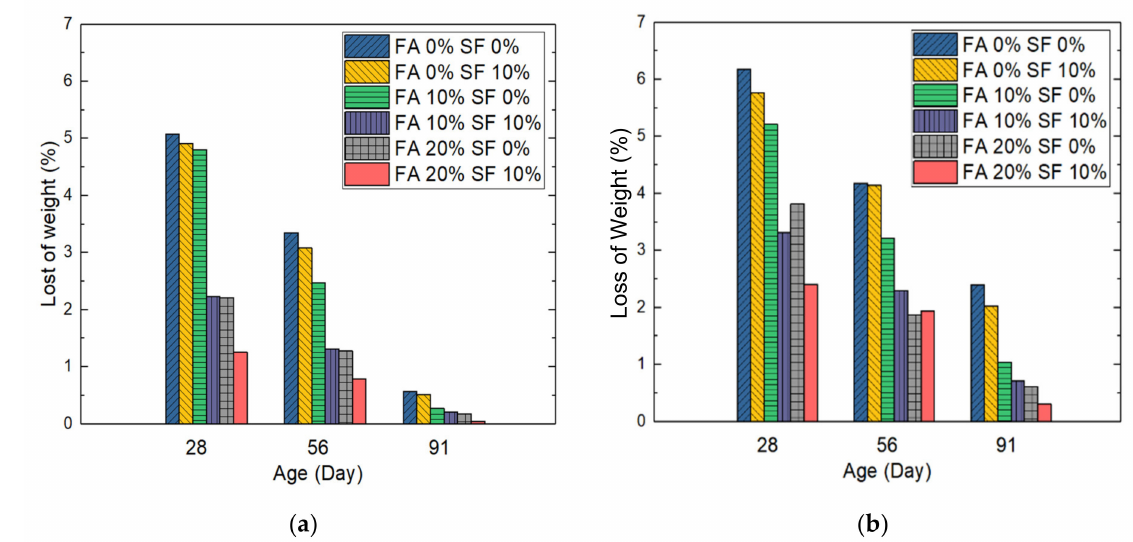
Figure 9. Loss of weight under sulfate-acid attacks of HPC samples with a water/binder (W/B) ratio of ( a ) 0.28 or ( b ) 0.30. Note: FA = fly ash; SF = silica